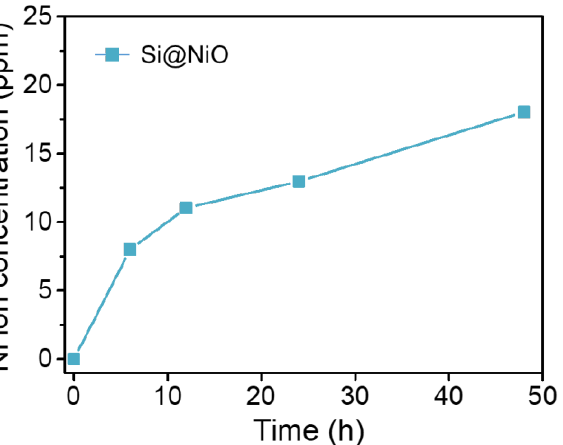
Figure 5. Metal ion release from Si@NiO nanoflowers. Concentration of Ni ions released from 1 mg/mL of Si@NiO in 0.9% saline solution.